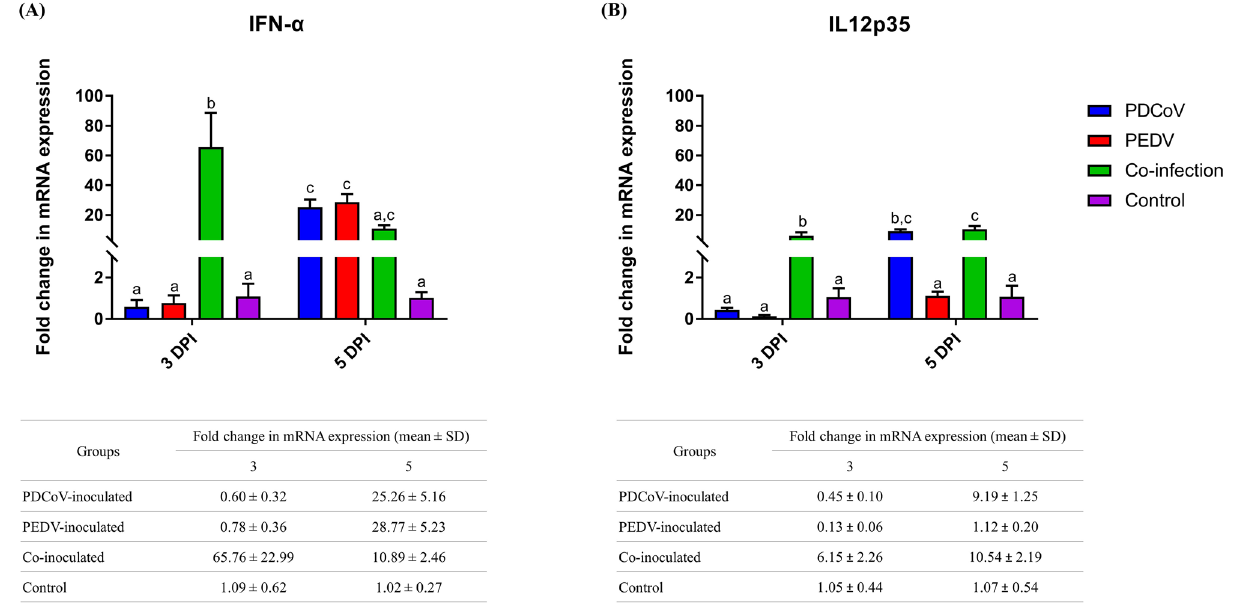
Figure 6. mRNA expression of proinflammatory cytokine genes on the intestinal mucosa of neonatal pigs. The mRNA levels of IFN-α ( A ) and IL12 ( B ) were determined using qPCR. Glyceraldehyde-3-phosphate dehydrogenase (GAPDH) and beta-actin were used as an internal control to normalize changes in specific gene expressions. The results were presented as fold changes relative to the control animals. Different lower-case letters indicate significant differences between each group and each dpi ( p < 0.05). Values of mean ± standard deviation (SD) of each group, and each dpi are presented in a table under the